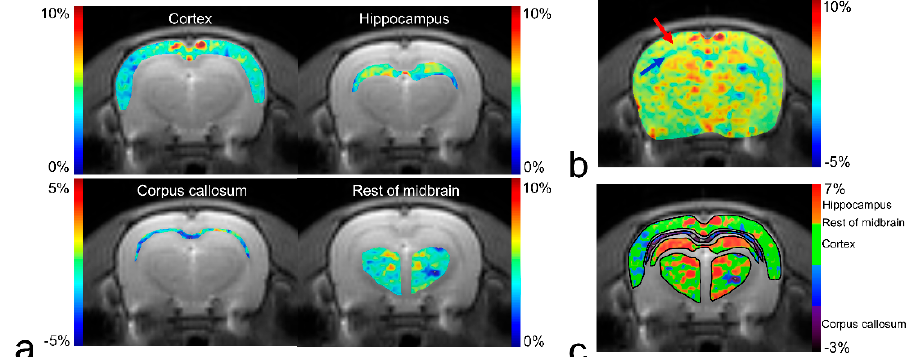
Figure 3. GluCEST maps for manually segmented brain regions ( a ) and whole-brain ( b ) using default color-scale bar (“Jet”) in MATLAB, and GluCEST map for segmented brain regions using a modified discrete color-scale bar ( c ) from a representative rat. The red arrow indicates the cortex, which is a representative gray matter region, and the blue arrow indicates the corpus callosum, which is a white matter region.